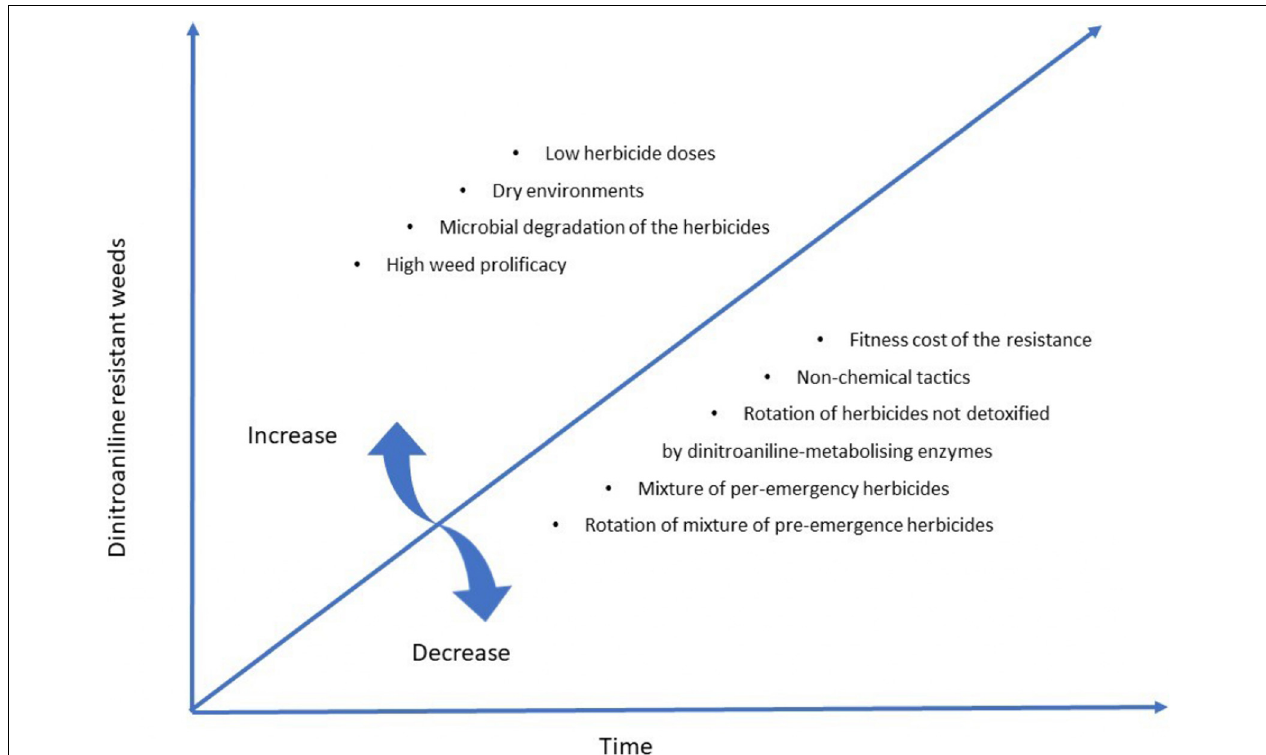
FIGURE 4 | Parameters associated with dinitroaniline resistance evolution in